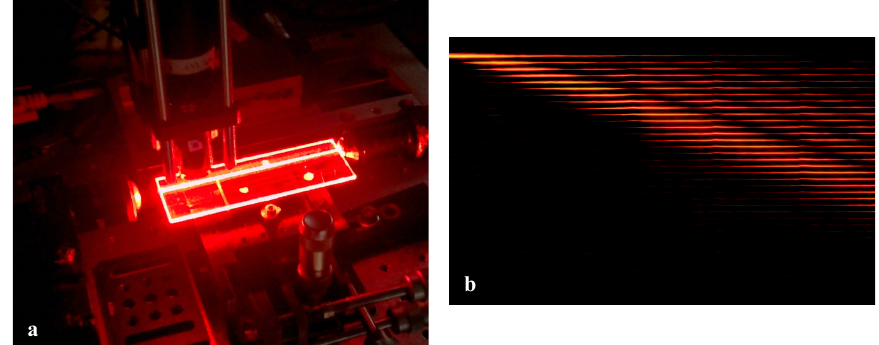
Figure 2. Coherent light from a He:Ne laser is injected in the array. To characterize the light distribution in the photonic structure, scattered light is imaged from above using a movable microscope-assembly that scans automatically the full length of the glass chip ( a ). Panel ( b ) reports an example of acquired intensity distribution from a waveguide array. The original image is monochrome and corresponds to a physical region of about 88 mm 640 µ m; here it is reshaped for better readability and shown in false × colors. A horizontal section yields the time evolution of a given state (waveguide). A vertical section gives the probability distribution within the photonic modes at a given time. Laser light is coupled in the array from the left in the topmost waveguide; the intensity of the first line in the picture thus corresponds to the survival probability of the initial state.